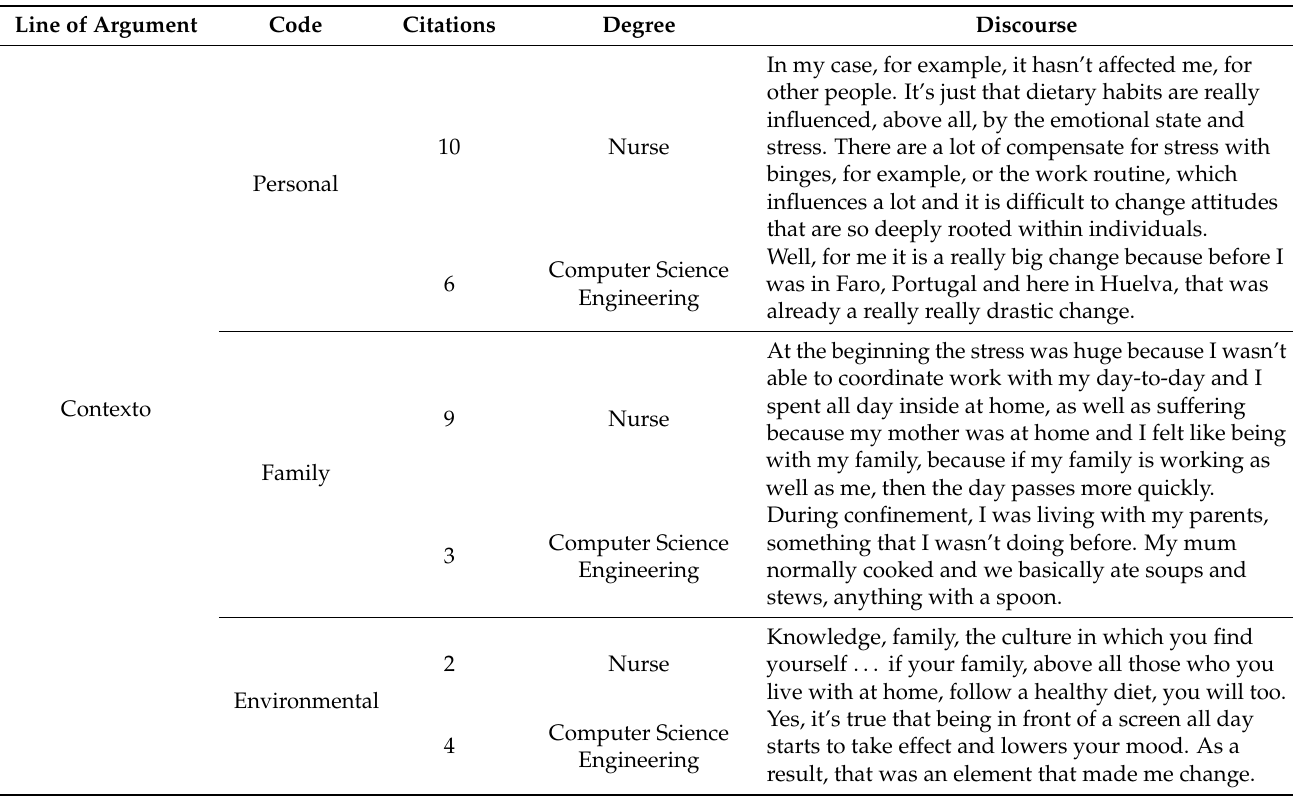
Table 3. Codes and nursing and engineering student discourse on the influence of the personal, family, and environmental